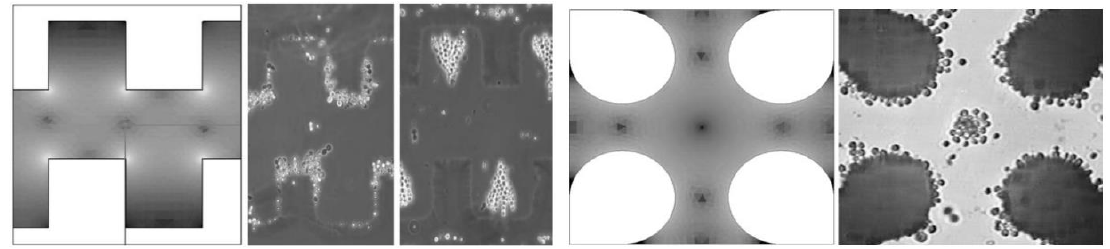
Figure 2. The lateral attraction dielectrophoresis (DEP) [30].